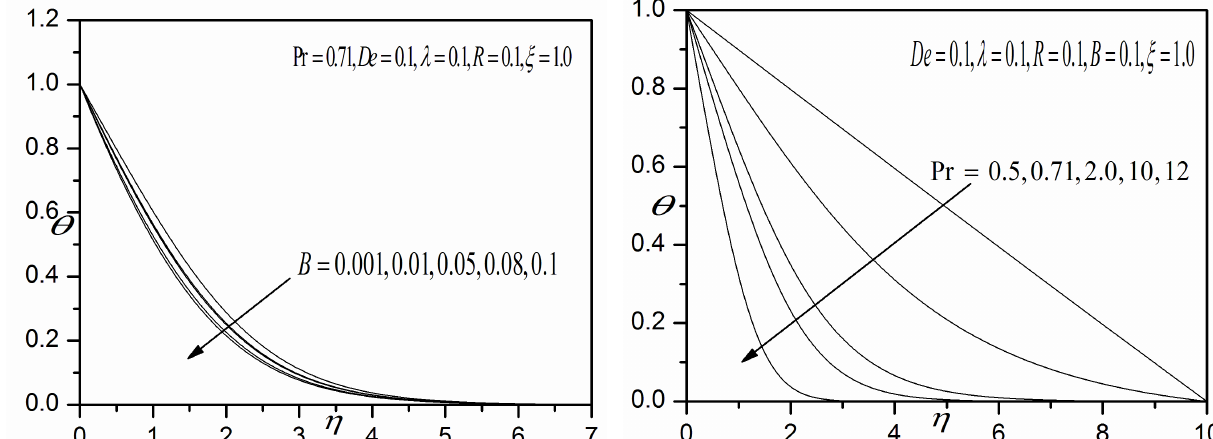
Fig. 15: Influence of Pr on the temperature.